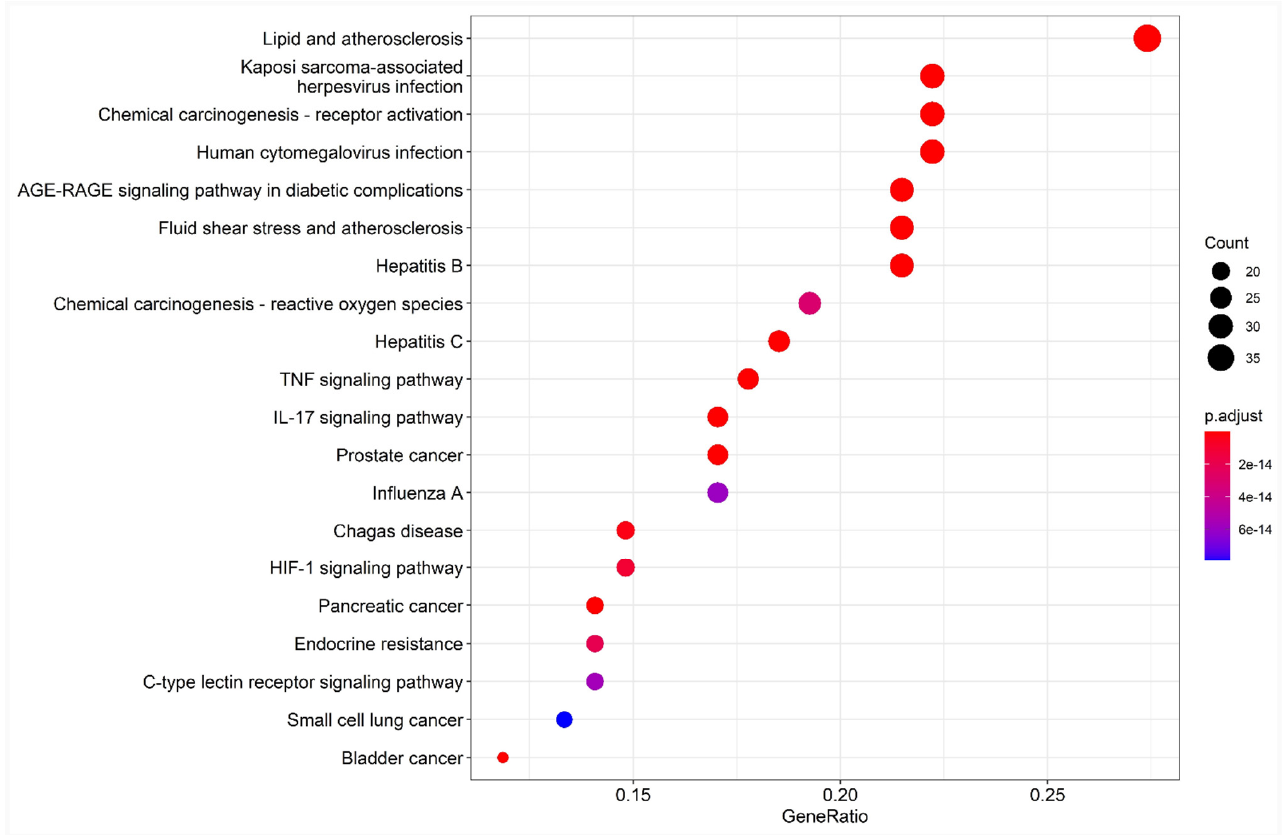
Figure 6. Bubble chart of KEGG pathway enrichment analysis. Note: the abscissa is the gene ratio, the ordinate is the enriched pathway, the size of the point represents the number of genes, and the color represents the level of p -value.